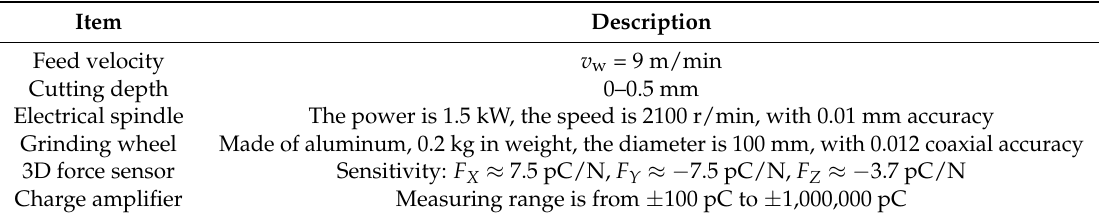
Figure 1. Schematic of the single grit scratching test system: ( a ) Experimental setup; ( b ) Force analysis of workpiece. Table 1. Experimental parameters and conditions.